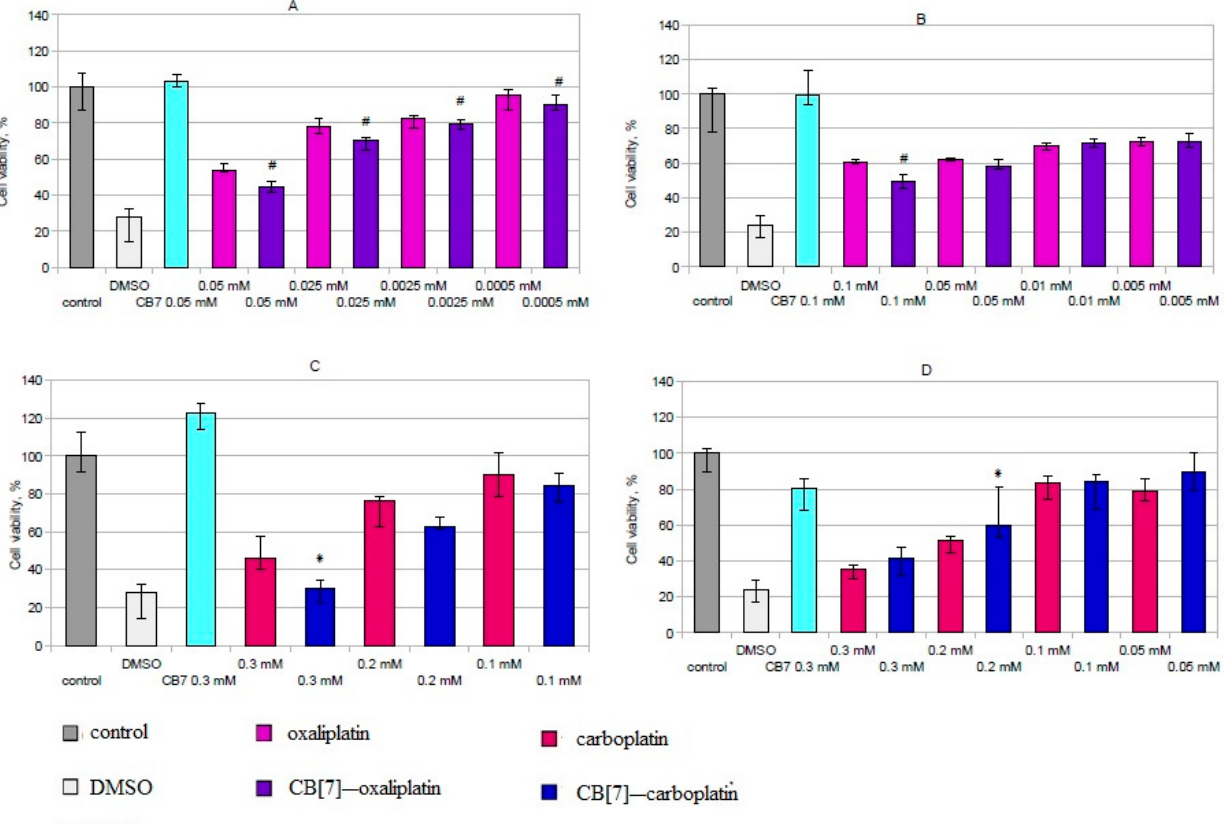
Figure 2. Effects of the CB[7] and platinum drugs on cell viability of different cell line. ( A ) Effects of the oxaliplatin–CB[7] complex on B16 cells’ viability. ( B ) Effects of the oxaliplatin–CB[7] complex on K562 cells’ viability. ( C ) Effects of the mixture of CB7 and carboplatin (1:1) on viability of B16 cells. ( D ) Effects of the mixture of CB7 and carboplatin (1:1) on viability of K562 cells. Data are expressed as the median with interquartile range. * Indicates a significant difference ( p < 0.05) vs. carboplatin. # Indicates a significant difference ( p < 0.05) vs. oxaliplatin.